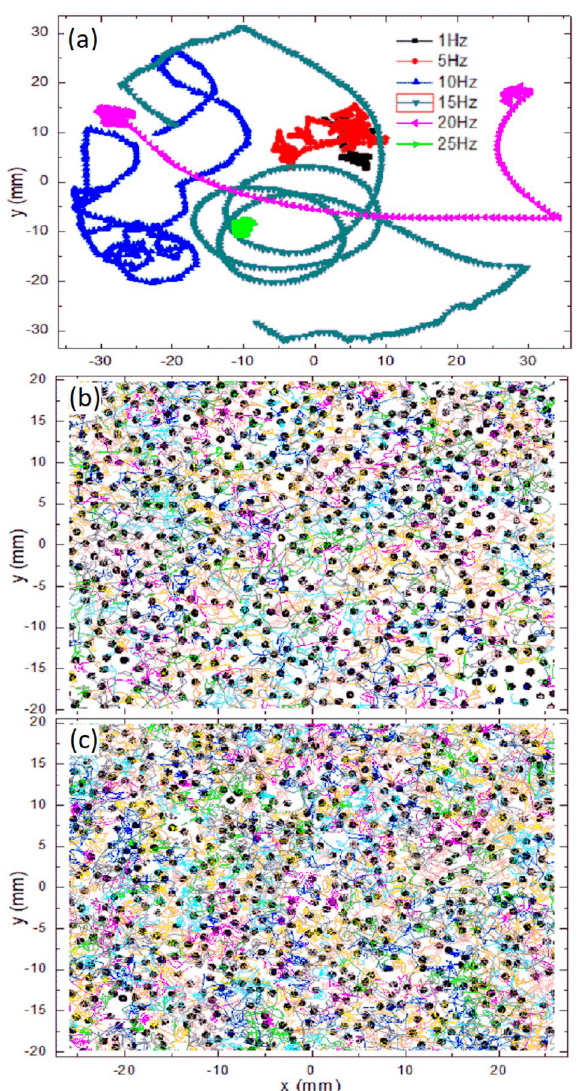
Figure 7. ( a ) Trajectories of a single particle on the glass plate at different frequencies. ( b ) Selected trajectories of a system of particles without constant magnetic field. ( c ) Selected trajectories of a system of particles in the presence of a constant magnetic field. Panel ( a ) shows trajectories for a duration of 8.33 s, whereas in panels ( b , c ) the duration is 1.66 s to avoid overlapping trajectories. The frequency in panels ( b , c ) is 10